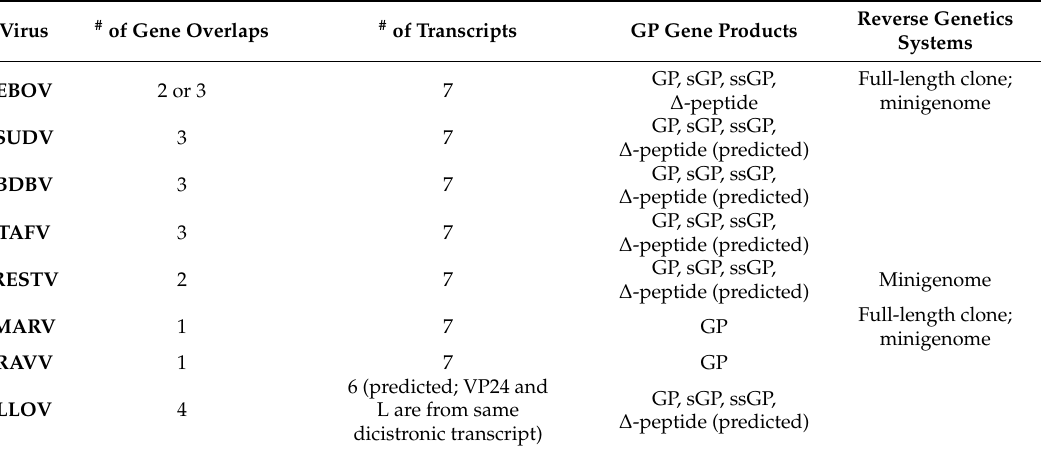
Table 5. Difference in genetic structure amongst